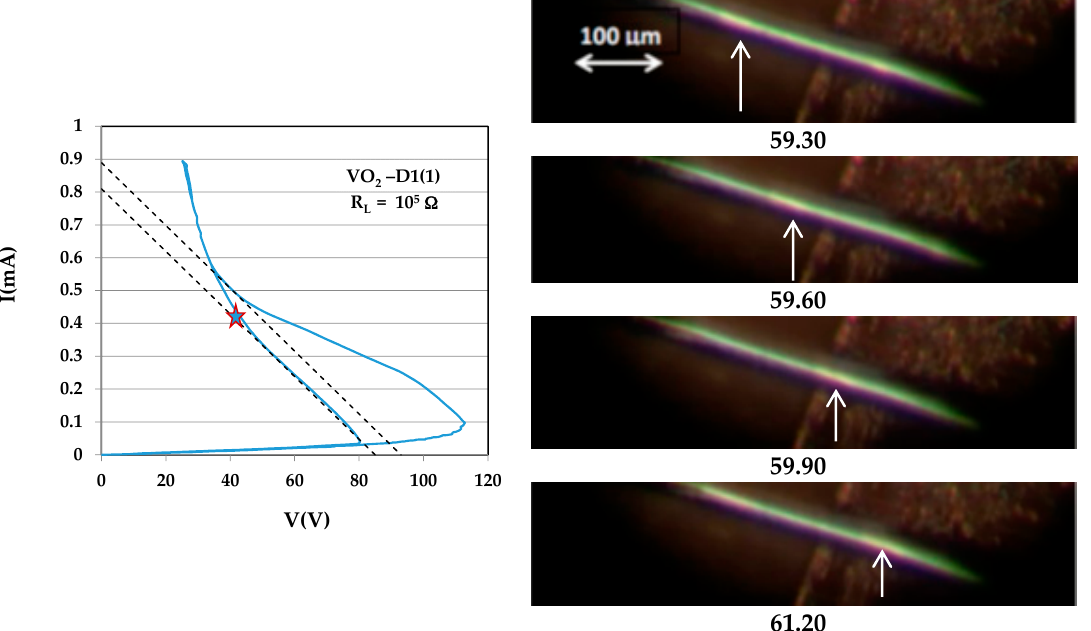
Figure 2. I–V characteristic of sample D1(1) and images of sliding domains snipped from a video 0.3 s apart at the point marked on the characteristic.